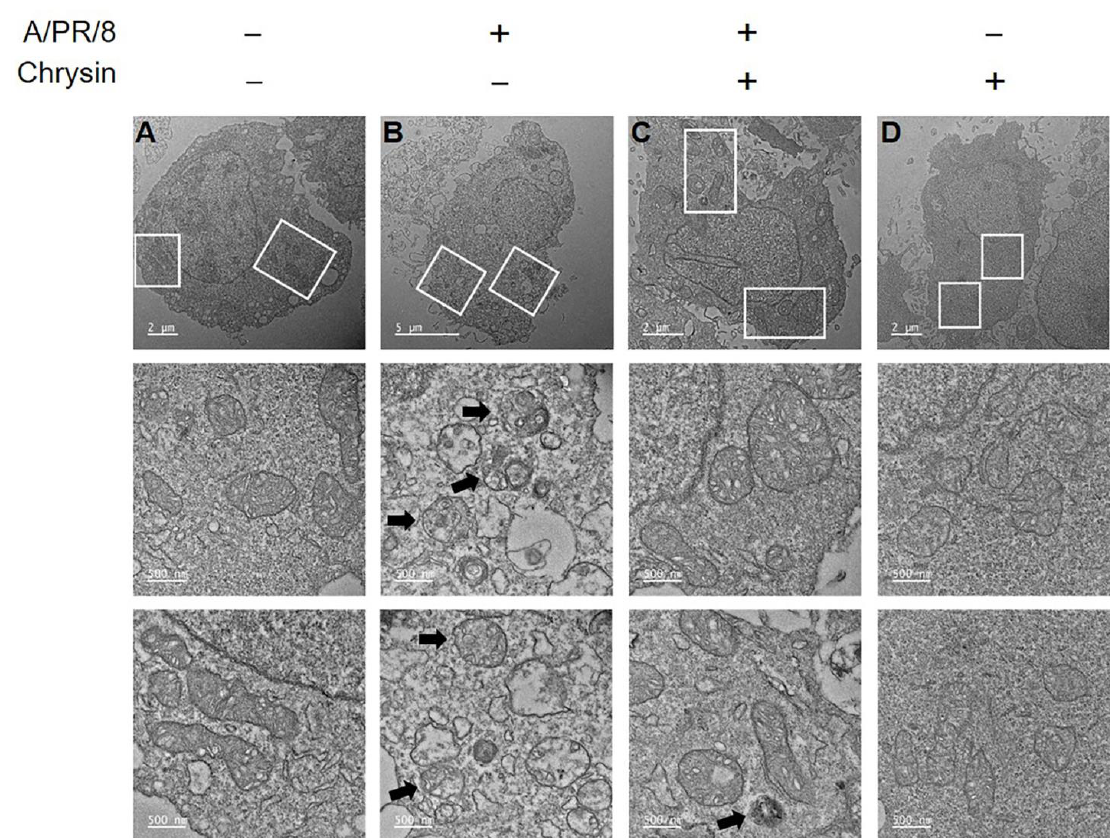
Figure 6. Analysis of autophagy using transmission electron microscopy (TEM). A549 cells infected with A/PR/8 were treated with 50 µM chrysin. After 24 h of treatment, the cells were rinsed with PBS, fixed, and processed for TEM. The white boxes in the upper images indicate the enlarged images shown below. The arrows indicate the sites of autophagy. ( A ) Non-infected cells. ( B ) A/PR/8-infected cells. ( C ) A/PR/8-infected cells treated with chrysin. ( D ) Non-infected cells treated with chrysin. Transmission electron micrographs at 5600× magnification are shown.